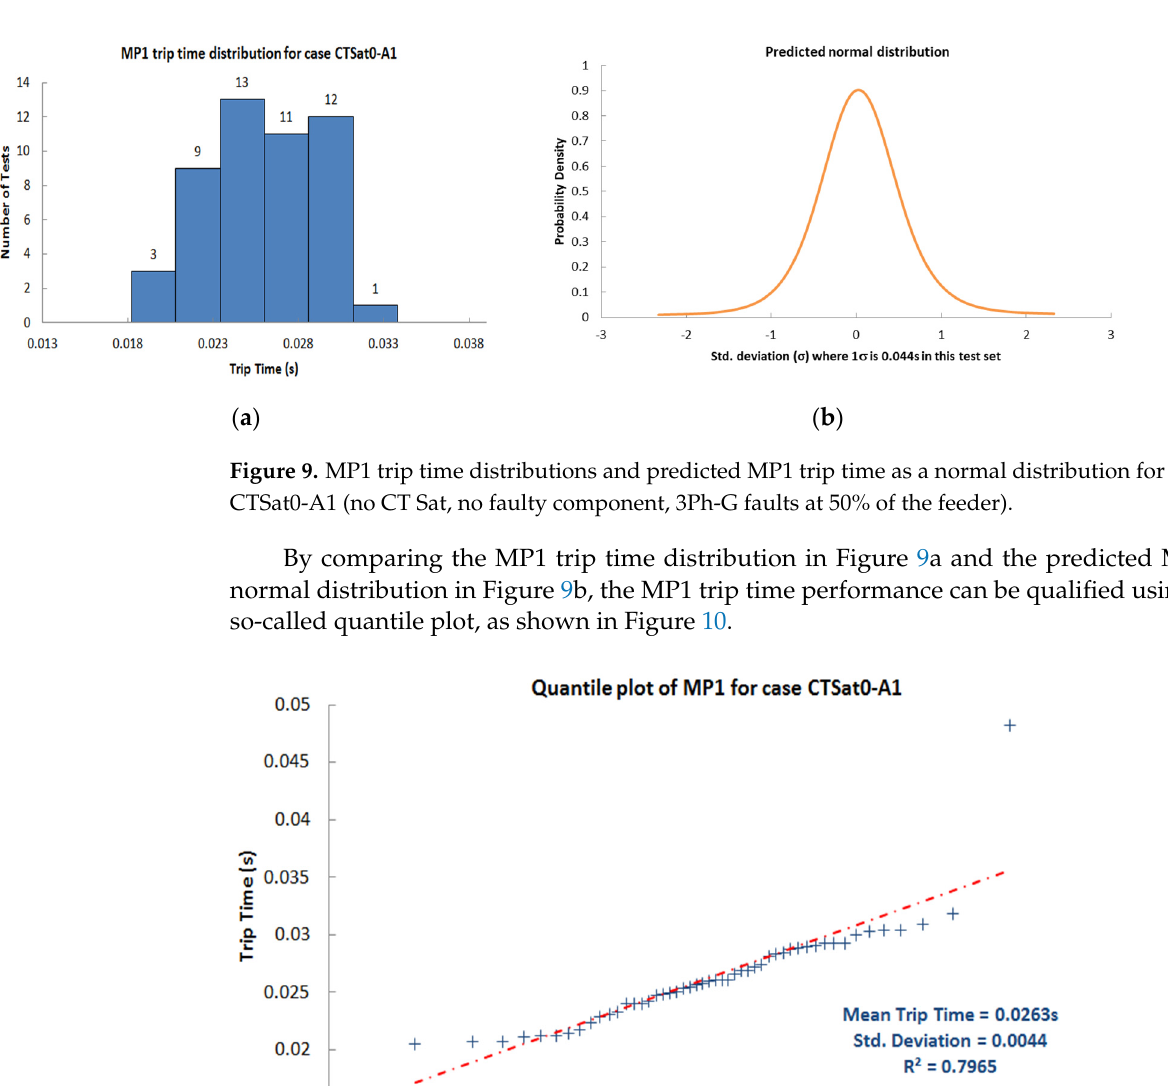
Figure 10. Quantile plot for case CTSat0-A1 (no CT Sat, no faulty component, 3Ph-G fault at 50% of the feeder).